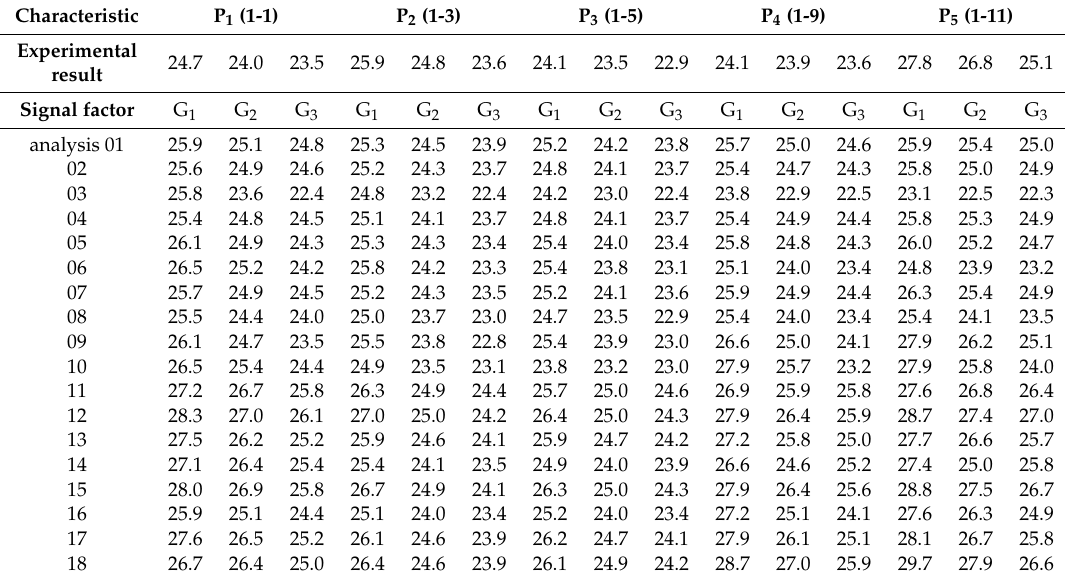
Table A1. Results of analysis based on DOE (first row).